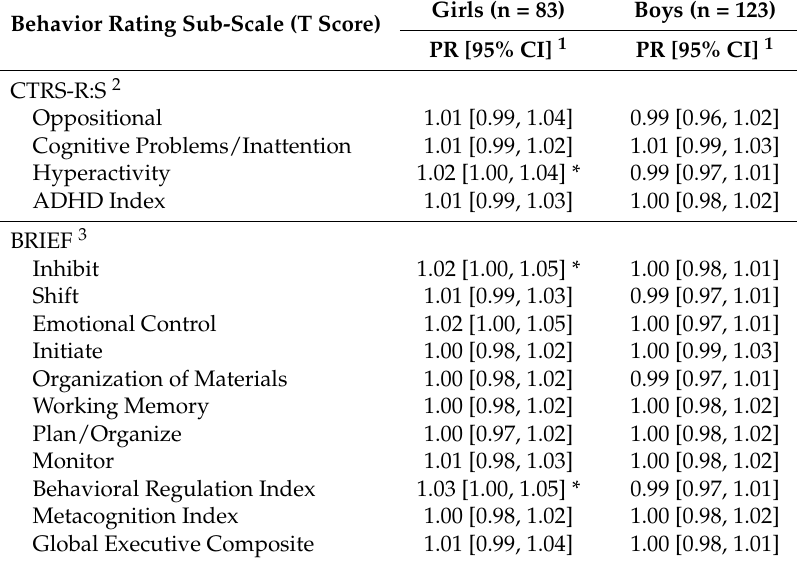
Table 4. Covariate-adjusted association (prevalence ratio) between blood lead concentrations and behavior ratings in boys and girls from Montevideo, Uruguay ( n =